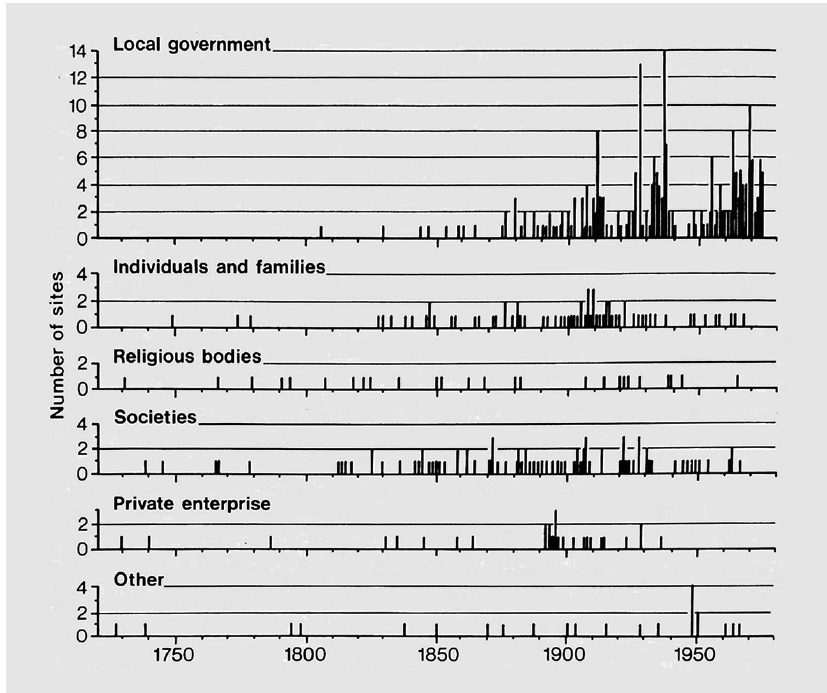
Figure 2. Agents developing institutional and public areas in Birmingham from 1730 to 1973. Source: Whitehand (1992, p.